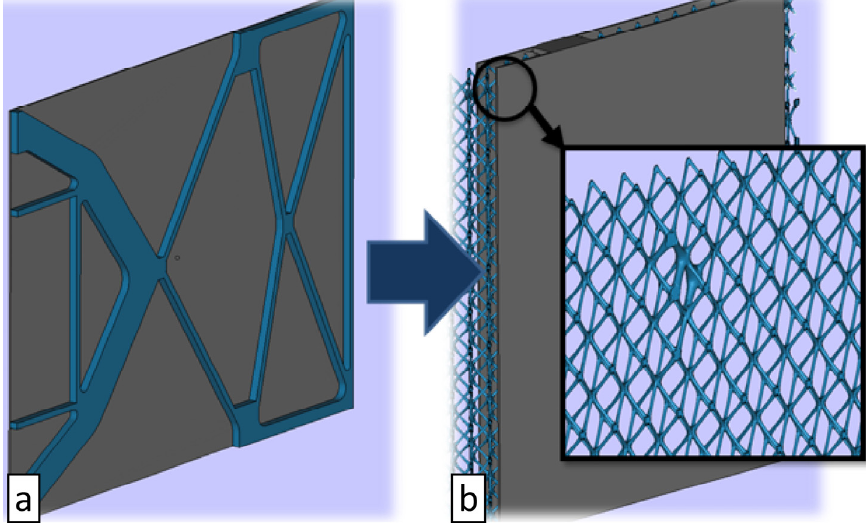
Figure 4. From traditional wall with ribs technology ( a ) to AM technology solution ( b